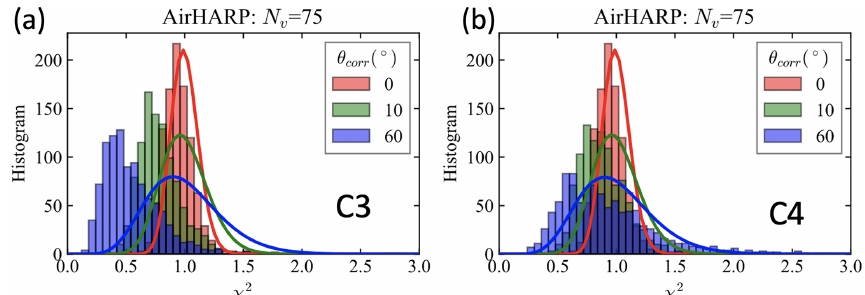
Figure 10. Cost function histogram with a correlation angle of 0, 10, and 60 ◦ for scenarios C3 (a) and C4 (b) . The average number of viewing angles from the 1000 simulation cases, after removing sunglint, is N v = 75 for the AirHARP measurement. The red line indicates the χ 2 distribution with a degree of freedom of 2 N v = 150. The green and blue lines indicate the χ 2 distribution with a reduced degree of freedom of 40 and 20 fitted to the corresponding histogram.